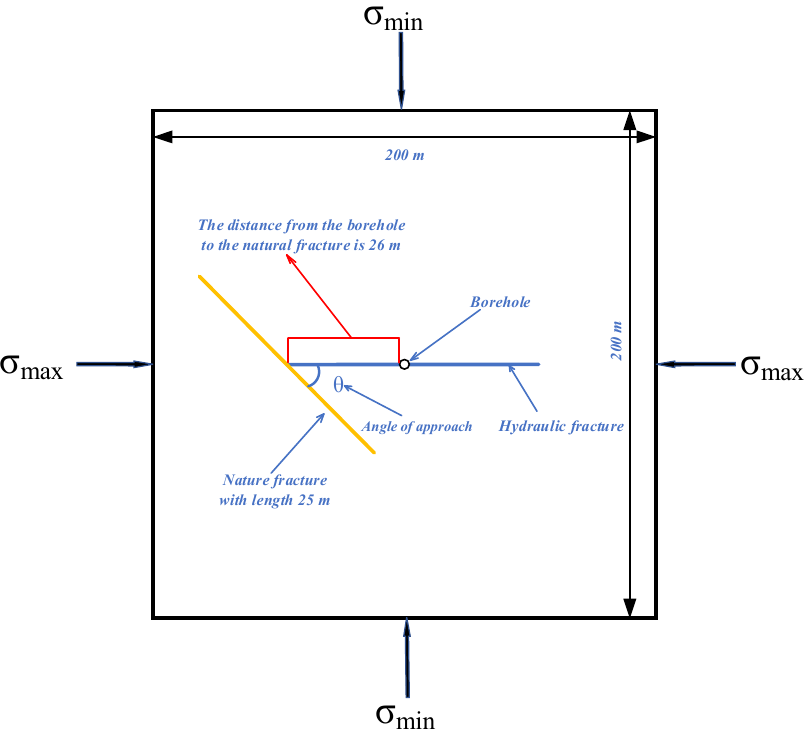
Figure 5. Model schematic diagram of validation case 2 [12]. Table 4. Mechanical properties in Zangeneh et al.’s numerical simulation [38].